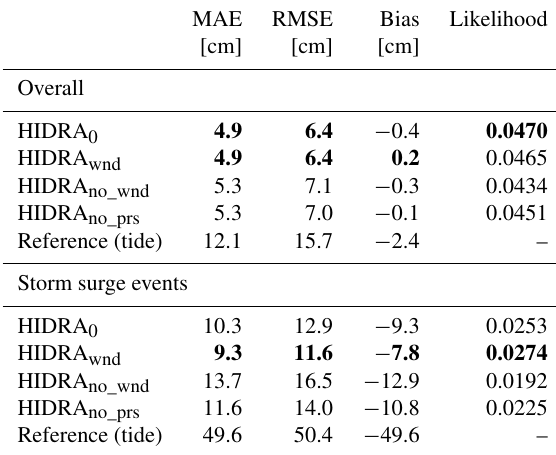
Table 7. Performance of HIDRA variants with different wind and pressure input configurations. HIDRA 0 uses the wind stress, HIDRA wnd uses the raw wind, HIDRA no_wnd does not use wind inputs and HIDRA no_prs uses the wind stress but not the air pres- sure. Performance of the astronomic tide is provided for reference. The best result in each category is denoted in bold.